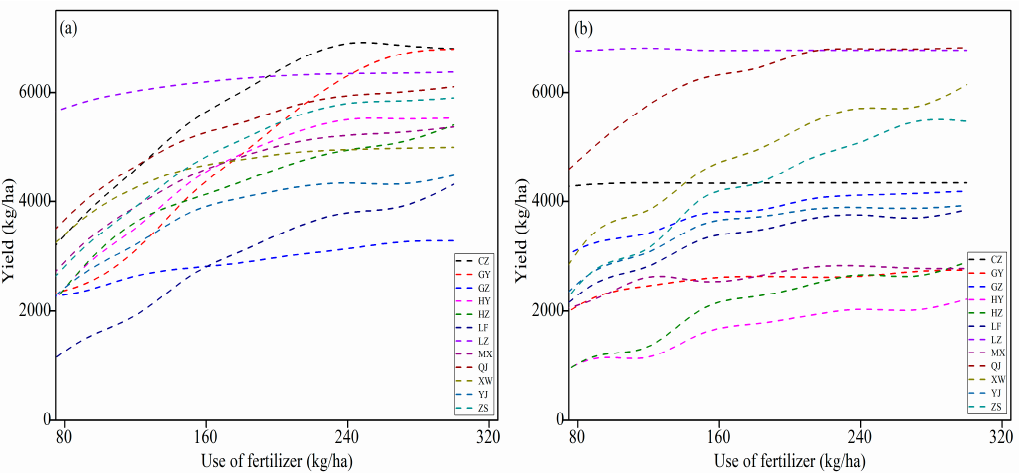
Figure 8. Simulated use of fertilizer and corresponding yields at each site for ( a ) early mature rice and ( b ) late mature rice.